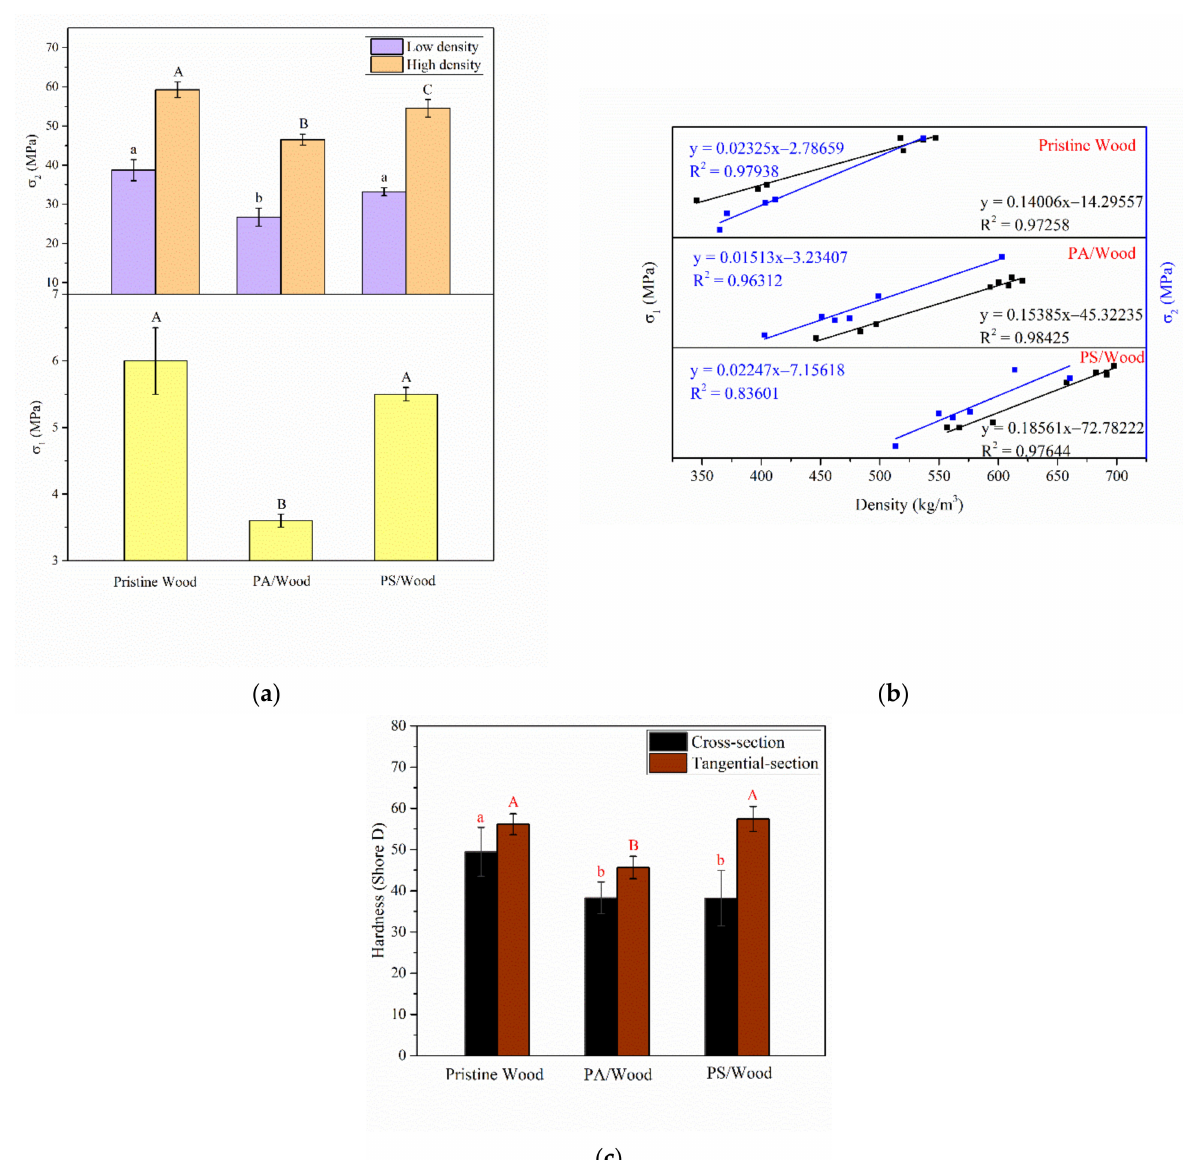
Figure 12. ( a ) Compressive strength ( σ 1 : perpendicular to the grain in the radial direction; σ 2 : parallel to the grain) of the wood samples; ( b ) dependencies of σ 2 on the density of each treated wood sample for different experimental groups; ( c ) shore hardness of the wood samples. Bars with different letters indicate a significant difference ( p < 0.05) in accordance with Duncan’s multiple range